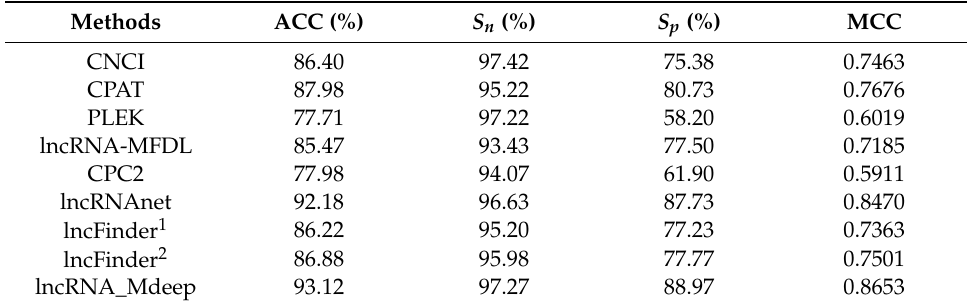
Table 2. Performance of lncRNA_Mdeep and other eight methods on humans in an independent test. Methods ACC